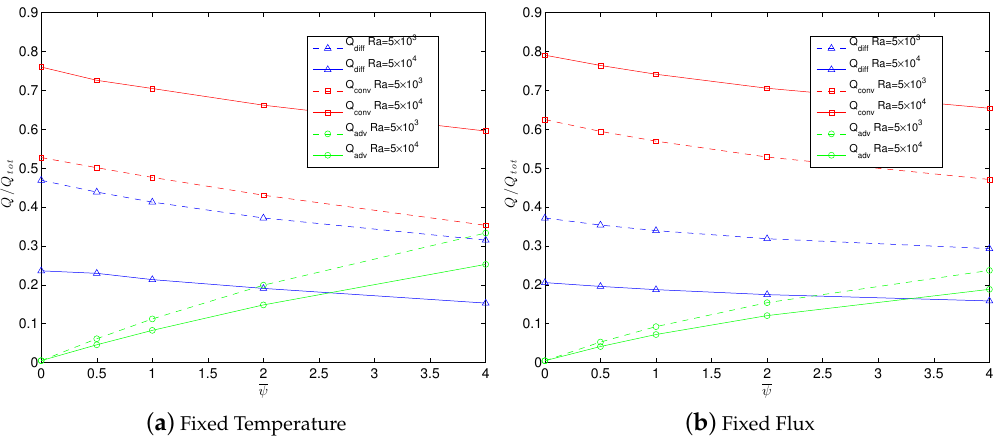
Figure 5. Heat flux components as a function of average chemical species concentration for TRLBM chemical convection simulations at two different Rayleigh numbers. The heat flux values (corresponding to diffusion in blue, convection in red and advection by passive scalar chemical species in green) are normalized by the total heat